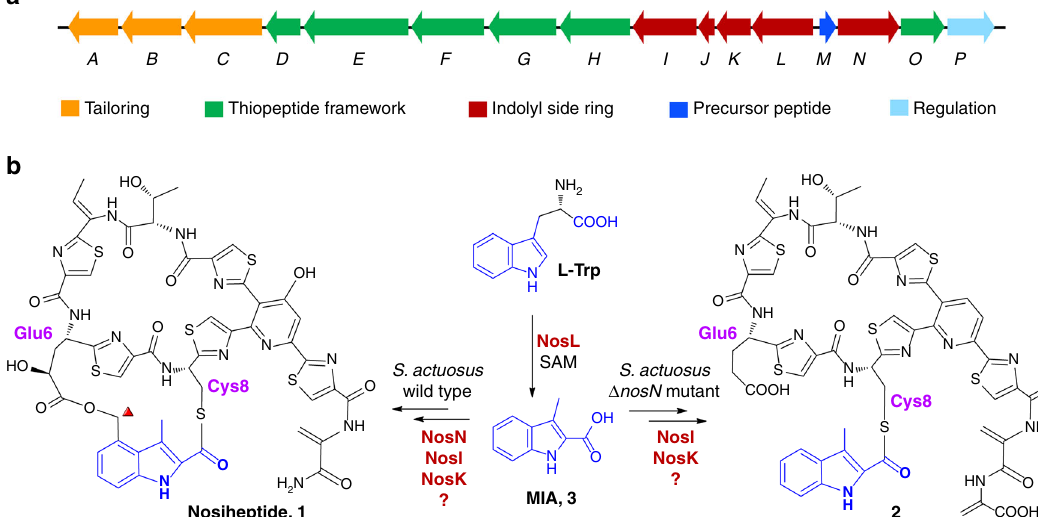
Fig. 1 Biosynthesis of nosiheptide by S. actuosus . a Organization of the nosiheptide biosynthetic gene cluster. Genes involved in the biosynthesis of the indolyl side ring ( nosI , nosJ , nosK , nosL and nosN ) are shown in red. b Nosiheptide contains an indolyl side ring that is not derived from the precursor peptide NosM. The NosL-derived indolic acid moiety (highlighted in blue) is a major component of the side ring, and the carbon atom introduced by the radical SAM methyltransferase NosN is highlighted with a red triangle. The nosN -knockout mutant of S. actuosus does not produce nosiheptide but an off-pathway product